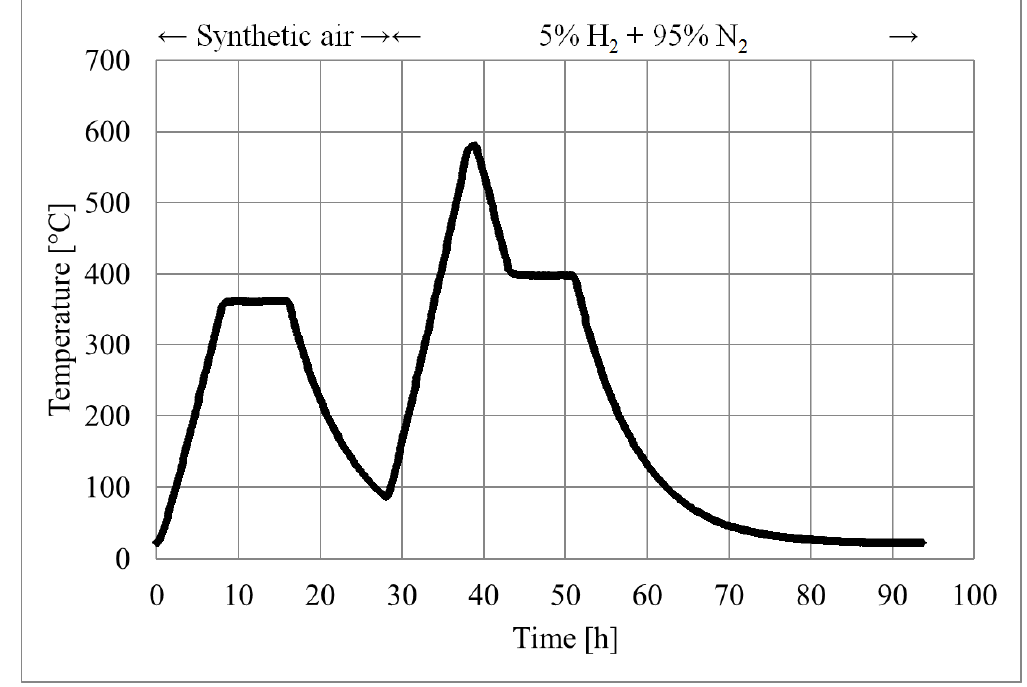
Figure 5. The temperature in the oven during the burn-off, the sintering and the reduction. The tape layer structure could be observed after the sintering, but the resulting wick was mechanically